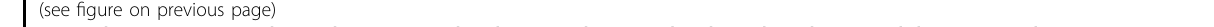
Fig. 3 The Der1 mutation dysregulates canonical pathways and genes related to schizophrenia and depression in heterozygous Der1 cortex. a Canonical pathway predictions for putative schizophrenia risk genes, and for orthologues of putative schizophrenia and depression risk genes that are dysregulated at the whole-gene and exon-level, as identi fi ed using DESeq2 + DEXSeq data. b , c Altered schizophrenia risk gene orthologue expression in the ‘ Synaptic long-term depression ’ and ‘ CREB signalling in neurons ’ canonical pathways, respectively. Double outlines indicate protein complexes and classes, the components of which can be found in Supplementary Table 2a, b. To provide additional information, genes encoding ionotropic glutamate receptor δ subunits (Grid), AMPA receptor subunits (AMPAR), voltage-gated calcium channel subunits (VGCC), calcium channels (CaCh), ionotropic glutamate receptor subunits (iGLUR) and structural synaptic components have been added to the pathways using the IPA ‘ Build ’ tool. *Genes identi fi ed by DEXSeq; red, dysregulated putative schizophrenia risk gene